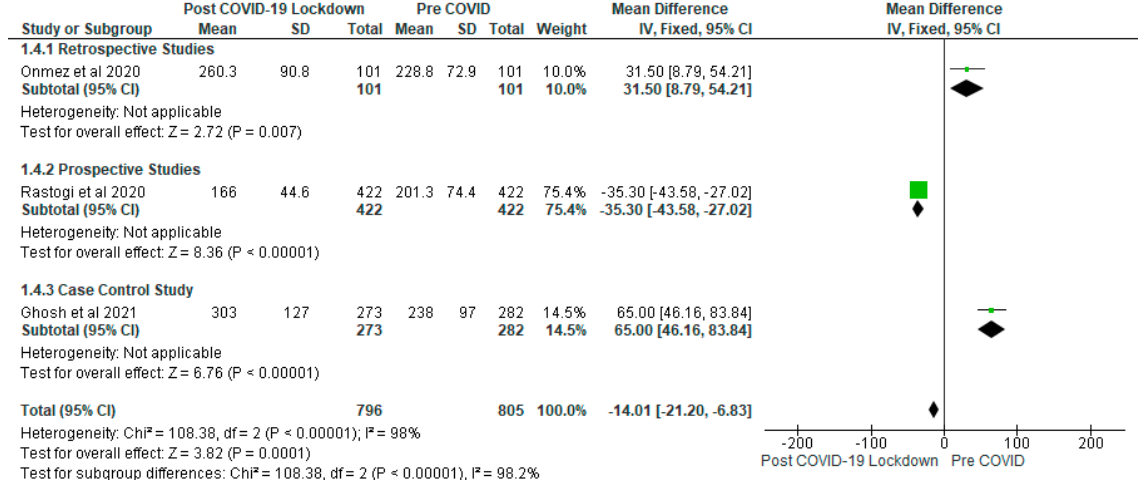
Figure 5. The effect of COVID-19 lockdown on Postprandial Blood Glucose (mg/dL).